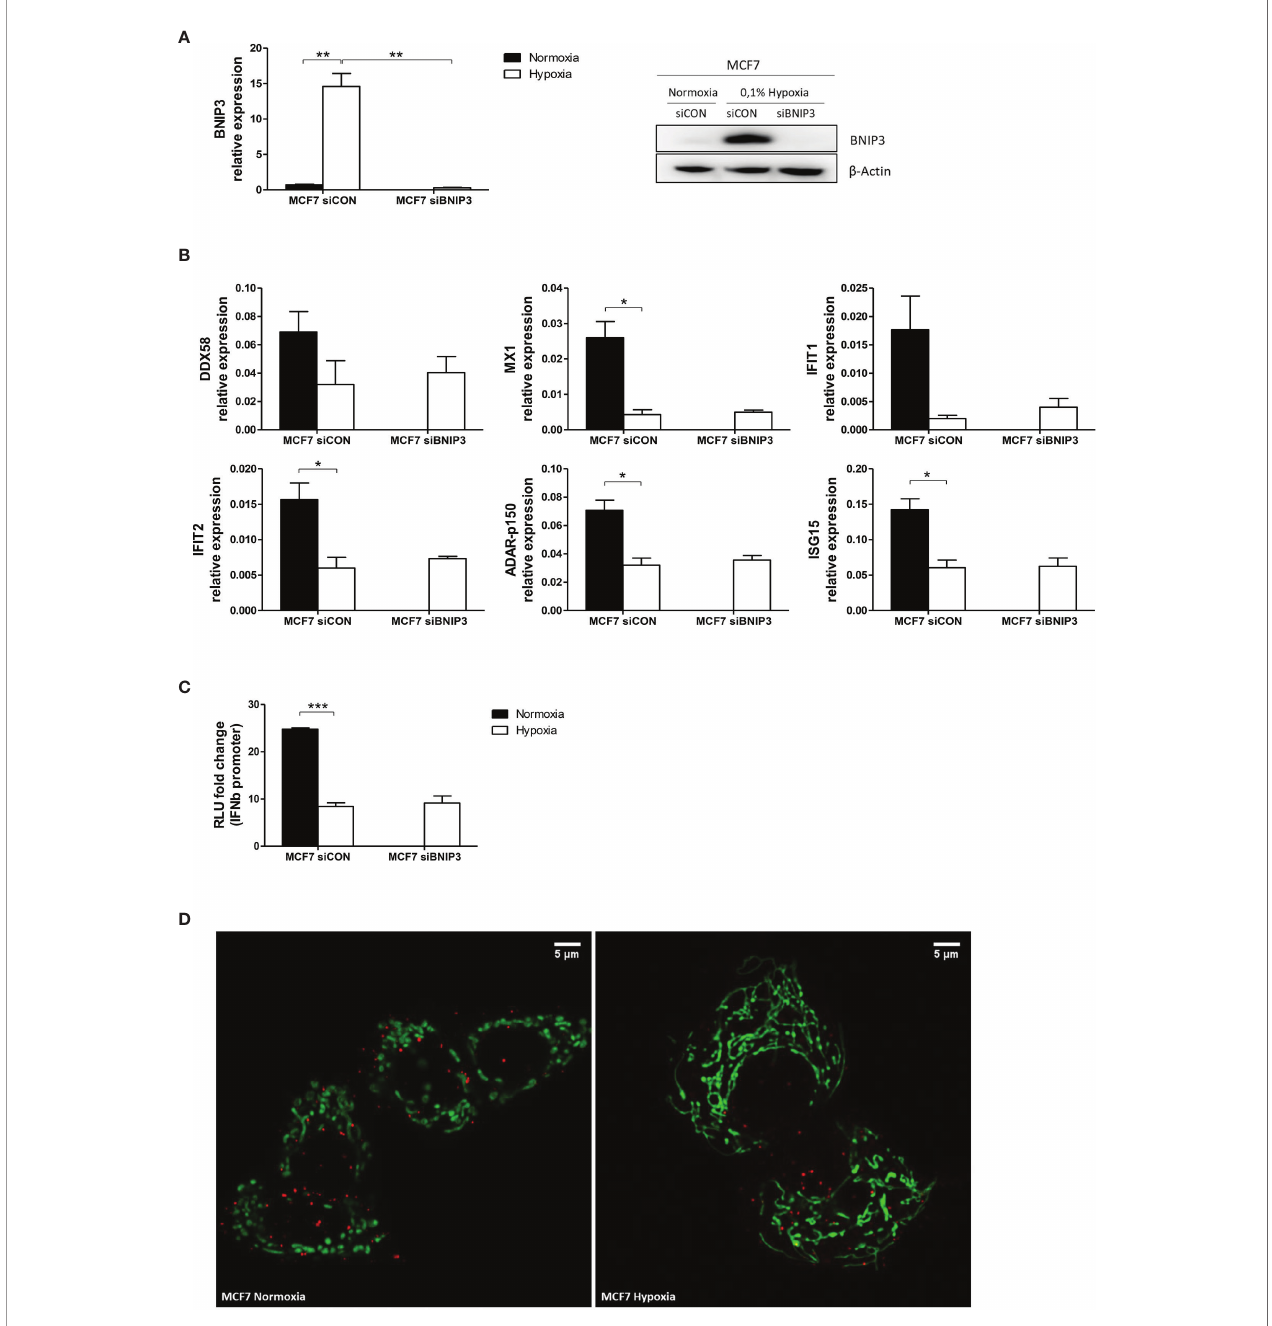
FIGURE 9 | Mitophagy is not involved in mtdsRNA reduction under hypoxia. (A) Silencing of BNIP3 was con fi rmed by qPCR (left panel) and western blot (right panel) in siBNIP3 MCF7 cells in hypoxia vs control (siCON) (n=3). (B) RNA expression of IFN-induced genes (ISGs) in siBNIP3 MCF7 cells vs siCON was performed by qPCR (n=3). (C) RNA from a) was used to evaluate IFN b promoter activation after BNIP3 silencing (n=3; RLU, relative light units). (D) Representative image showing lack of colocalization between the mitochondrial (green) and lysosomal (red) markers in MCF7 cells exposed to normoxia or 0.1% hypoxia for 48h (n=3). Number of replicates indicate biological replicates and data is shown as mean ± SEM. *p < 0.05, **p < 0.01, ***p < 0.001. Scale bars correspond to 5 m